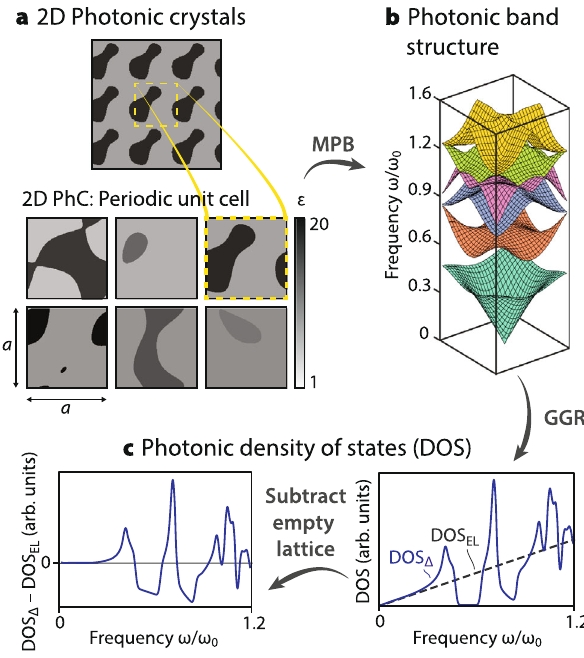
Fig. 3 2D photonic crystals dataset generation. a We generated 20000 square 2D PhC unit cells using a level set of Fourier sums, giving two-tone permittivity pro fi les ε ( r ) ∈ { ε 1 , ε 2 } with ε i ∈ [1, 20]. 7000 of these unit cells were randomly selected; b their TM photonic band structures were computed via MPB, and c their corresponding density-of-states (DOS) were computed. The DOS spectrums were then smoothed, standardized, and the “ empty-lattice ” DOS were subtracted from them to derive the labels of the